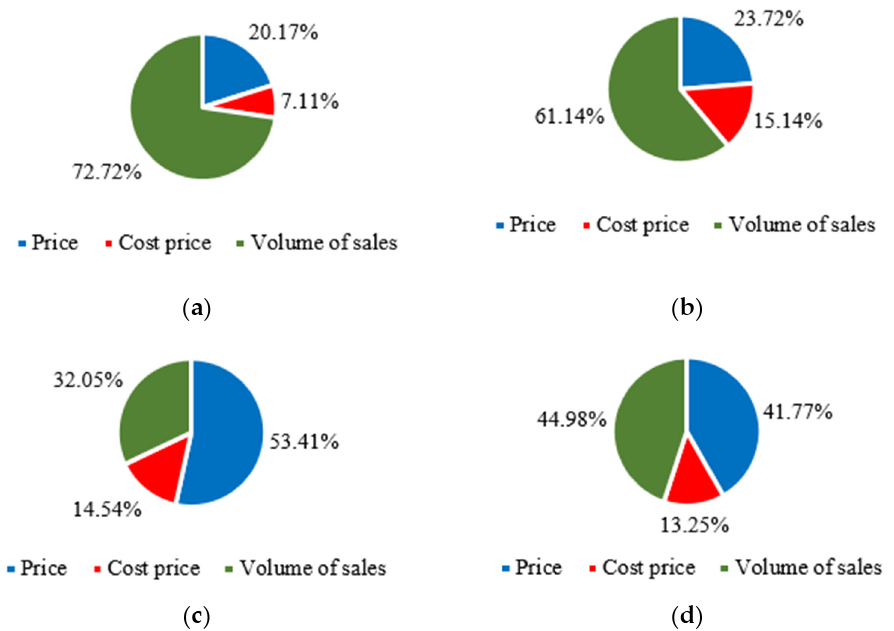
Figure 13. Correlation of factor changes: ( a ) wheat noodles; ( b ) cellophane noodles; ( c ) pork tender- loin; ( d ) beef.